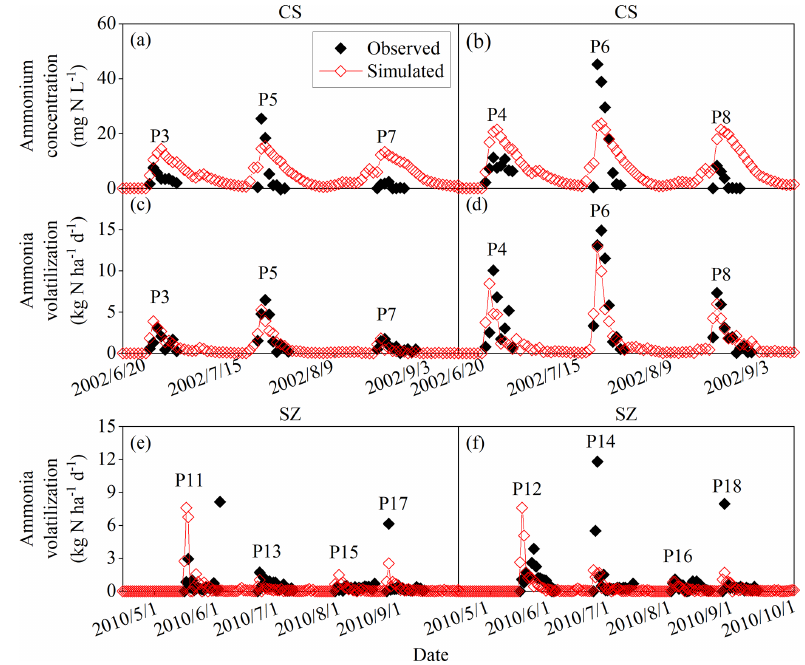
Figure 4. Observed and simulated ammonium concentrations of floodwater and daily ammonia volatilization from the urea application for CS and SZ. The definitions of the case codes refer to Table 2. The sites are Changshu (CS) and Shenzhen (SZ).